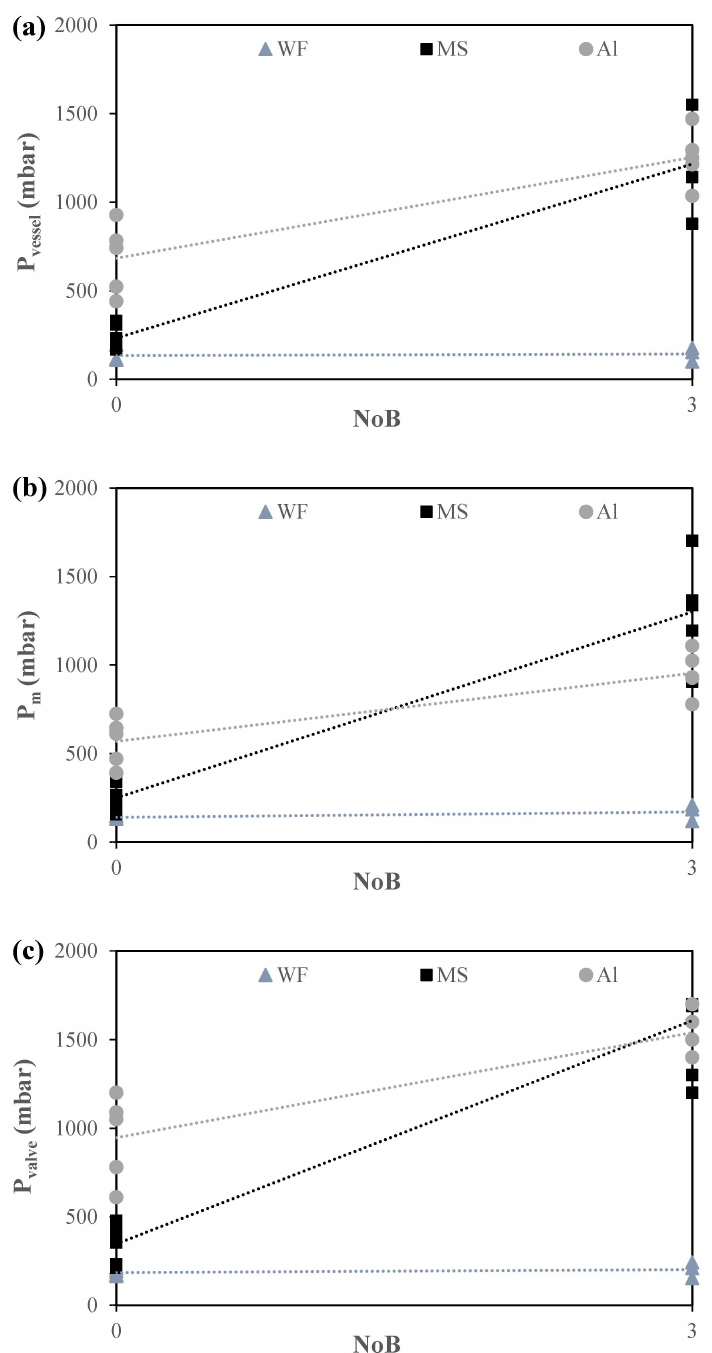
Figure 6. Influence of bends (R/D ratio of 0.6) on pressure for each dust: ( a ) pressure in the vessel (P 1 ), ( b ) pressure in the middle of the duct (P 2 ), ( c ) pressure near the valve (P 3